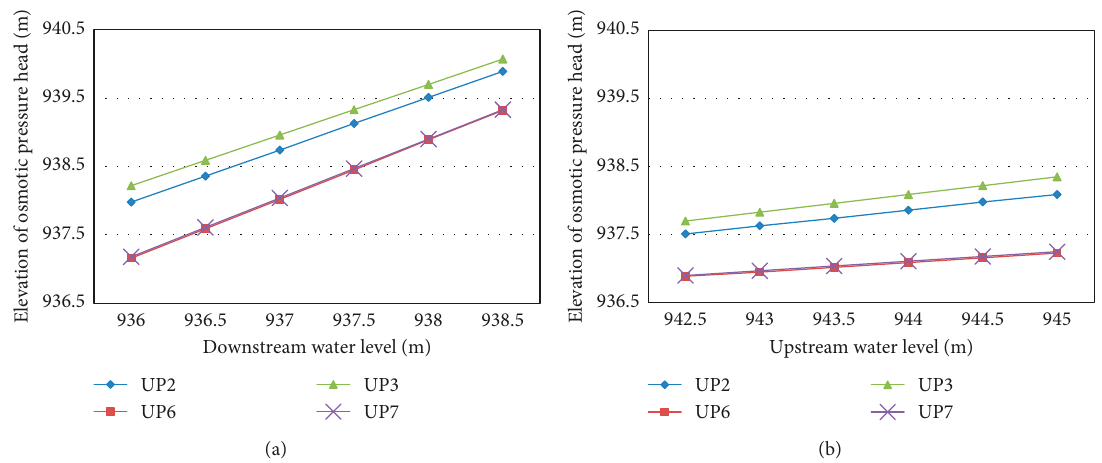
Figure 19: (a) Effects of downstream water level on seepage pressure at the measuring points UP2, UP3, UP6, and UP7. (b) Effects of reservoir water level on seepage pressure at the measuring points UP2, UP3, UP6, and UP7.